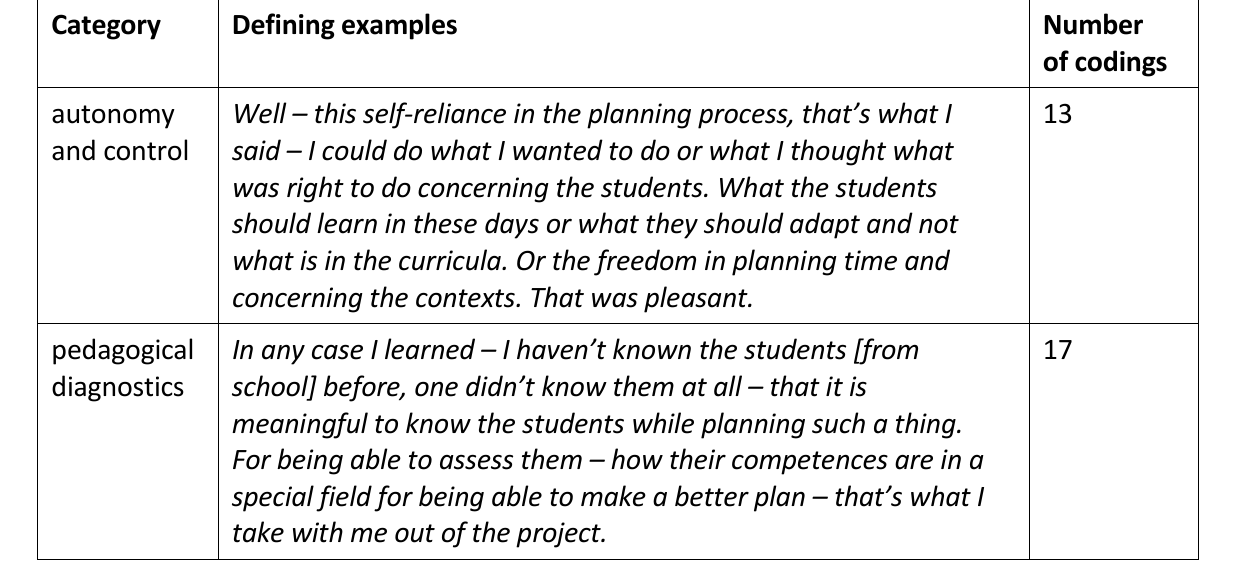
Table 1. Defining examples of codings